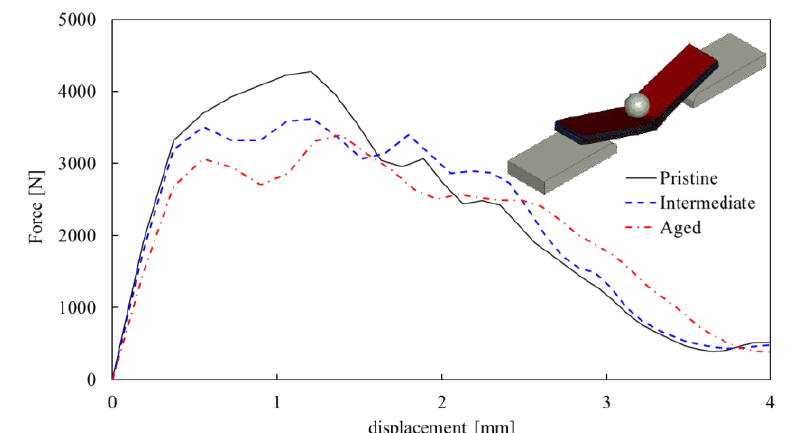
Fig. 4 . Results of D3PB simulations on the IM7/8552 cross-ply beam at an impact velocity of 75 m/s. The solid black line represents the pristine material with no hygrothermal ageing; the dashed blue line represents an intermediate state of damage; and the dotted red line represents the fully aged